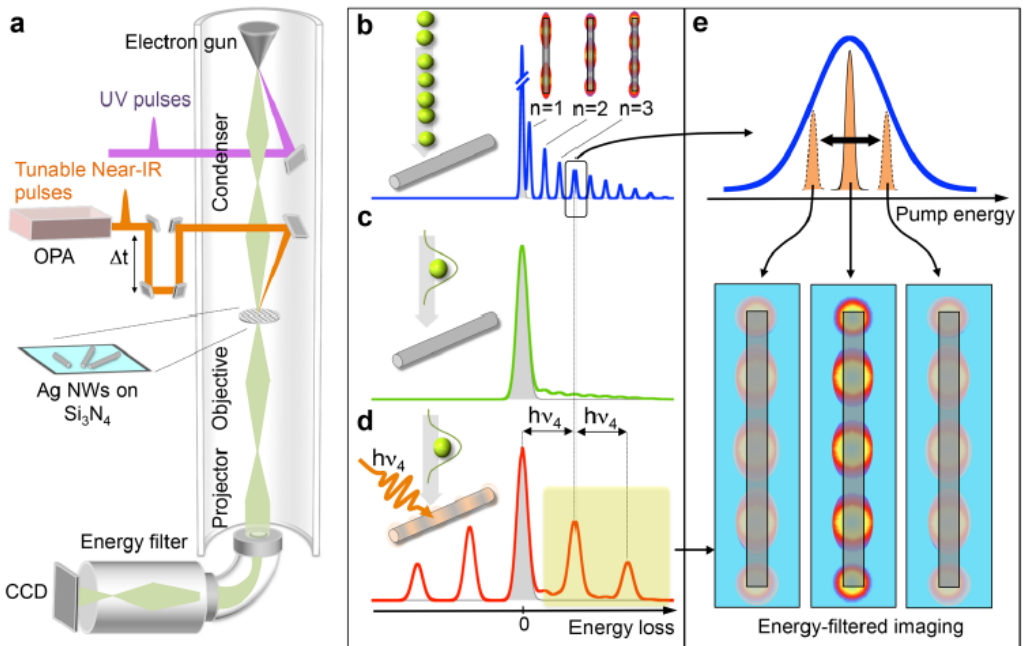
Figure 5. Spectrally resolved PINEN [52]. ( a ) Experimental scheme. ( b ) Electron energy-loss spectroscopy (EELS) spectrum revealing multiple plasmon resonances in an individual nanowire excited by passing electrons and mapped by raster scanning the electron beam (plasmon map insets). ( c ) Sketch of an electron energy loss (EEL) spectrum of the sample under ultrafast energy-filtered microscopy conditions. The visibility of electron-induced plasmon resonances is severely reduced. ( d ) Sketch of an EEL spectrum of the specimen (e.g., long silver nanowire (130 nm diameter, 7.8 μm length) deposited on a Si 3 N 4 membrane) upon photoexcitation by light pulses (e.g., the pump with 100 fs, 1.08 eV, and 5 mJ/cm 2 laser pulses from an optical parametric amplifier) of energy h ν 4 , tuned to the n = 4 plasmon-resonance frequency. This specific mode exchanges several times its characteristic energy with electrons. ( e ) Concept of the experiment in [52]: the laser excitation wavelength is scanned and the plasmon resonance profile is retrieved via quantitative analysis of the energy-filtered images in UEM. Reprinted (adapted) with permission from work in [52]. Copyright (2018) American Chemical Society.